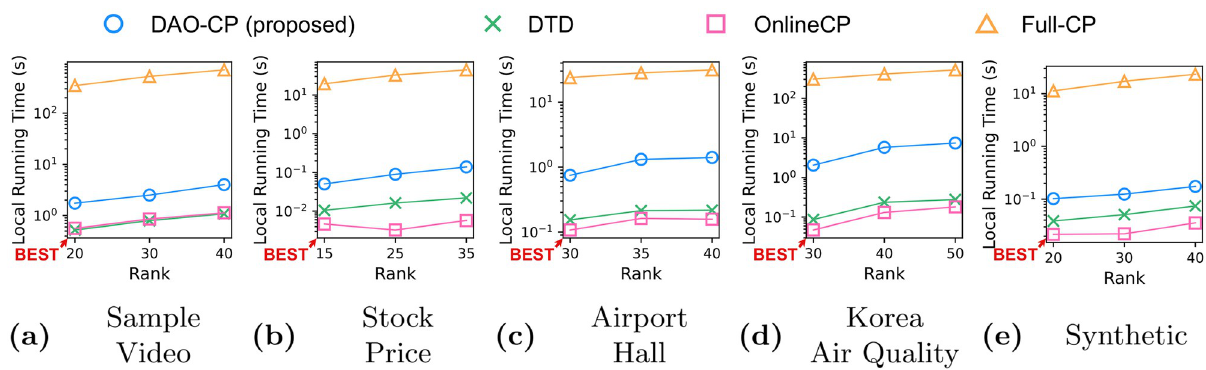
Fig 5. Time cost: Average of local running time. Since Full–CP is not an online method, we evaluate its fitness whenever a new slice is added. Note that DAO-CP results in a promising speed comparable to DTD and OnlineCP with much more accurate decomposition, and significantly faster than Full–CP.